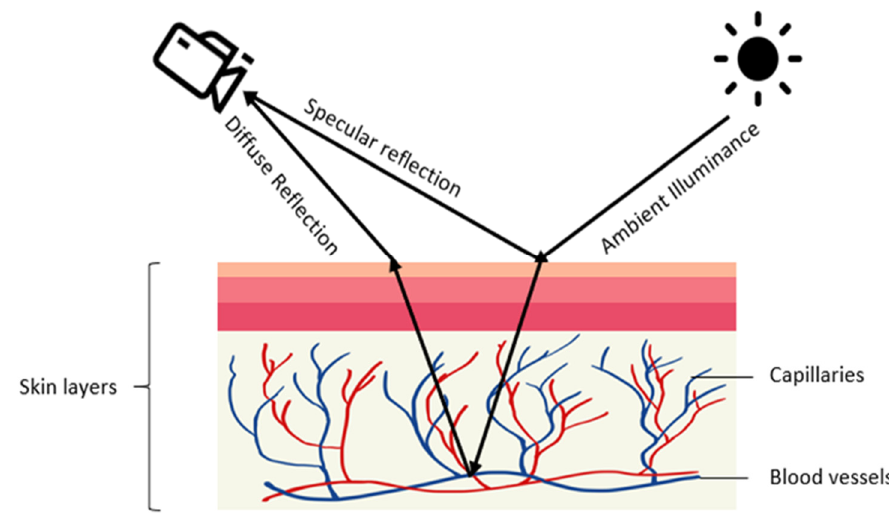
Figure 2. Illustration of rPPG generation: diffused and specular reflections of ambient illuminance are captured by a camera with the diffused reflection indicating volumetric changes in blood vessels.